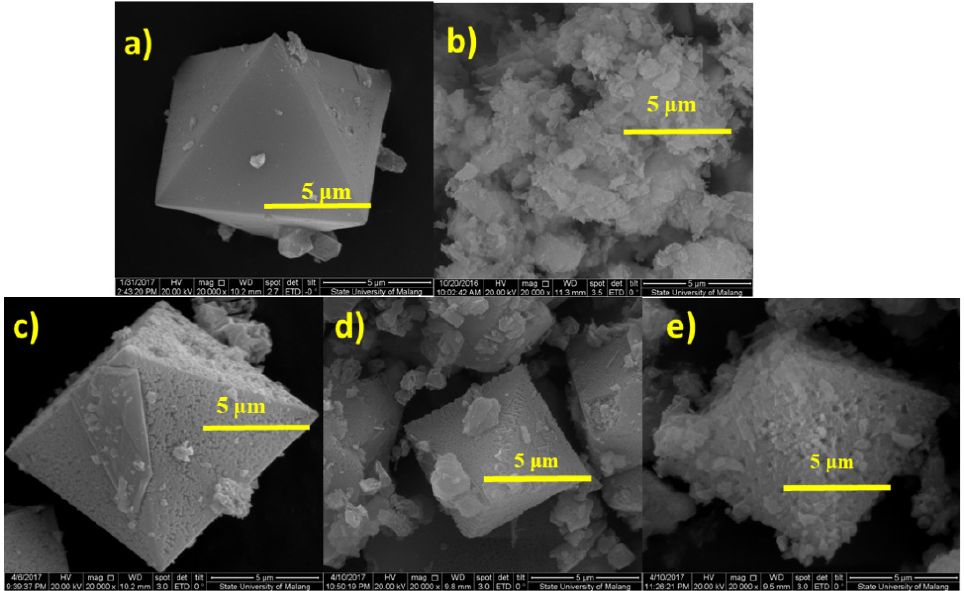
Figure 2 : FTIR spectra of HKUST-1, ANZ, and ANZ@ HKUST-1 composites with various ANZ additions.